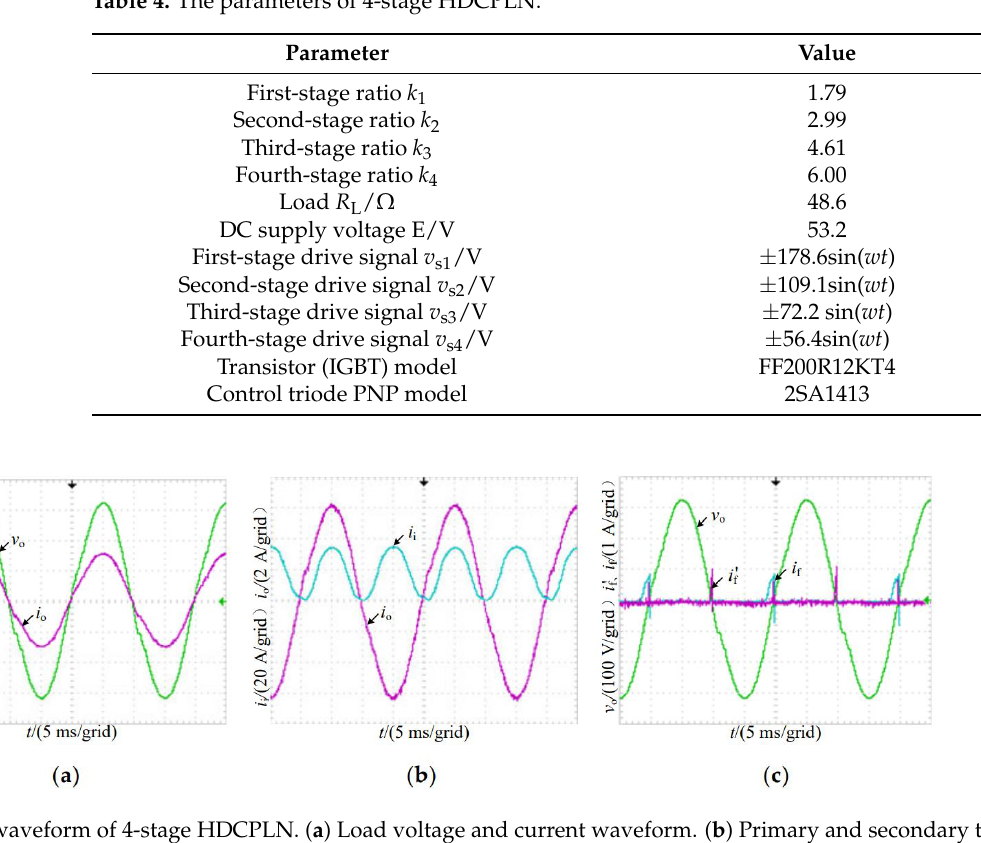
Table 4. The parameters of 4-stage HDCPLN.